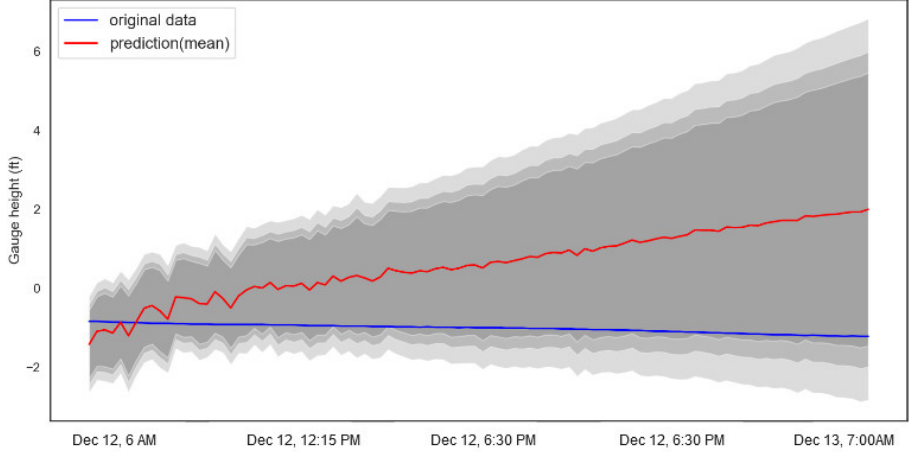
Figure 10. Forecasts with uncertainty estimations.